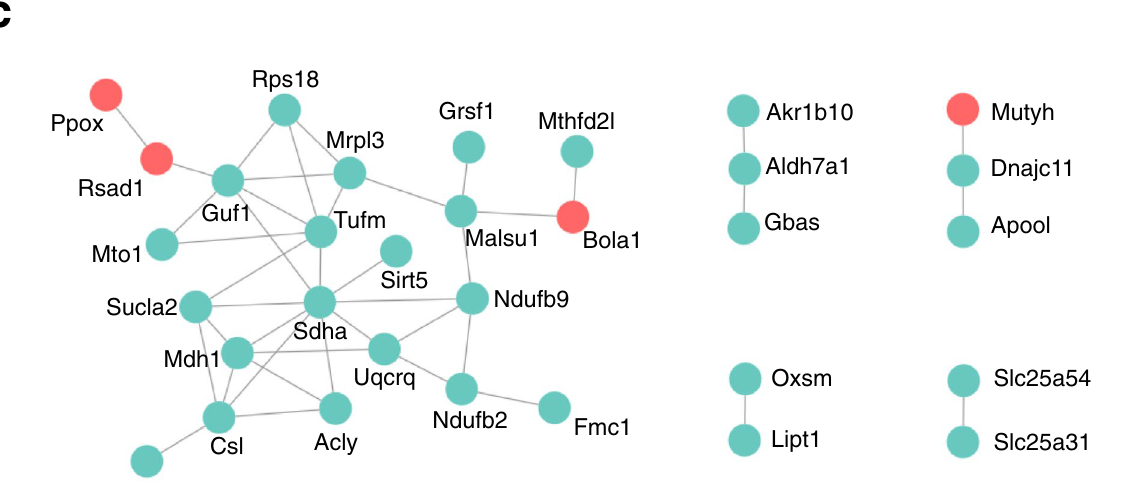
Figure 6. Iron supplementation alters the transcription of mitochondrial genes associated with the iron prosthetic groups in the liver and skeletal muscle. ( a – c ) Male C57BL/6J mice of 6 weeks of age were fed with each diet for 15 weeks as specified in Fig. 1. For each group, a mix of all sample cDNAs was used. ( a ) Venn diagrams showing upregulated expression of 51 mitochondrial genes in the liver and skeletal muscle of HF + SFC compared with HF (greater than or equal to 1.5-fold). Mitochondrial genes were based on the MitoCarta2.0 database. ( b ) STRING enrichment analysis of 51 upregulated mitochondrial genes in the liver and skeletal muscle of HF + SFC revealed in ( a ) (FDR < 0.05). Arrows point to the iron prosthetic groups related pathways. UniProt database was used. The analysis was performed by Cytoscape. ( c ) The STRING networks of 51 upregulated mitochondrial genes in the liver and skeletal muscle of HF + SFC revealed in ( a ). These networks are annotated with energy generation and ETC using BiNGO ( p < 0.001). The iron prosthetic group related genes (red) and other genes (green) are shown. The analysis was performed by